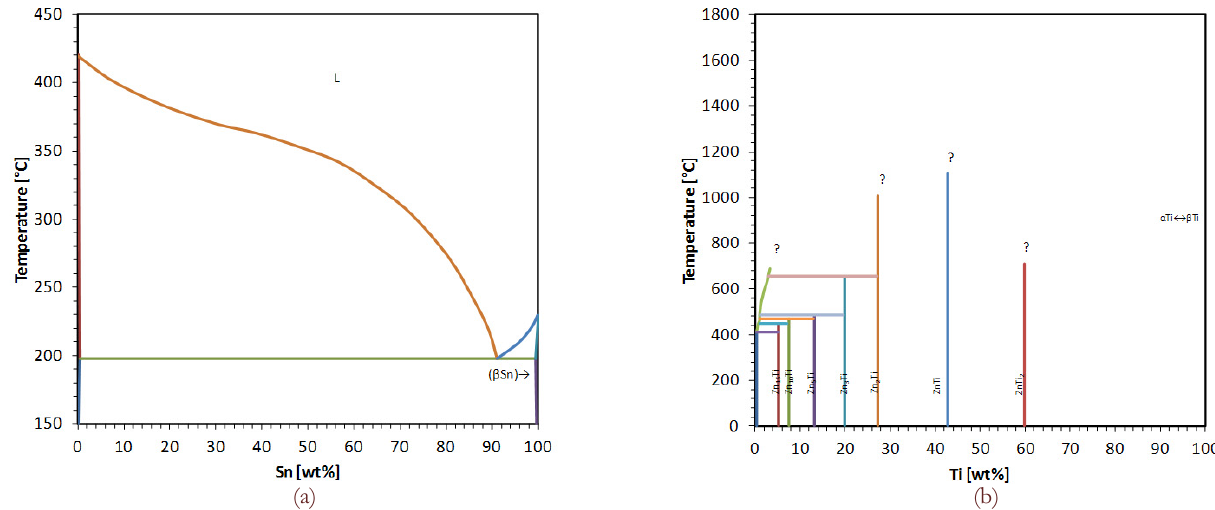
Figure 2: Equilibrium phases diagrams [11]: a) Zn-Sn alloys, b) Zn-Ti